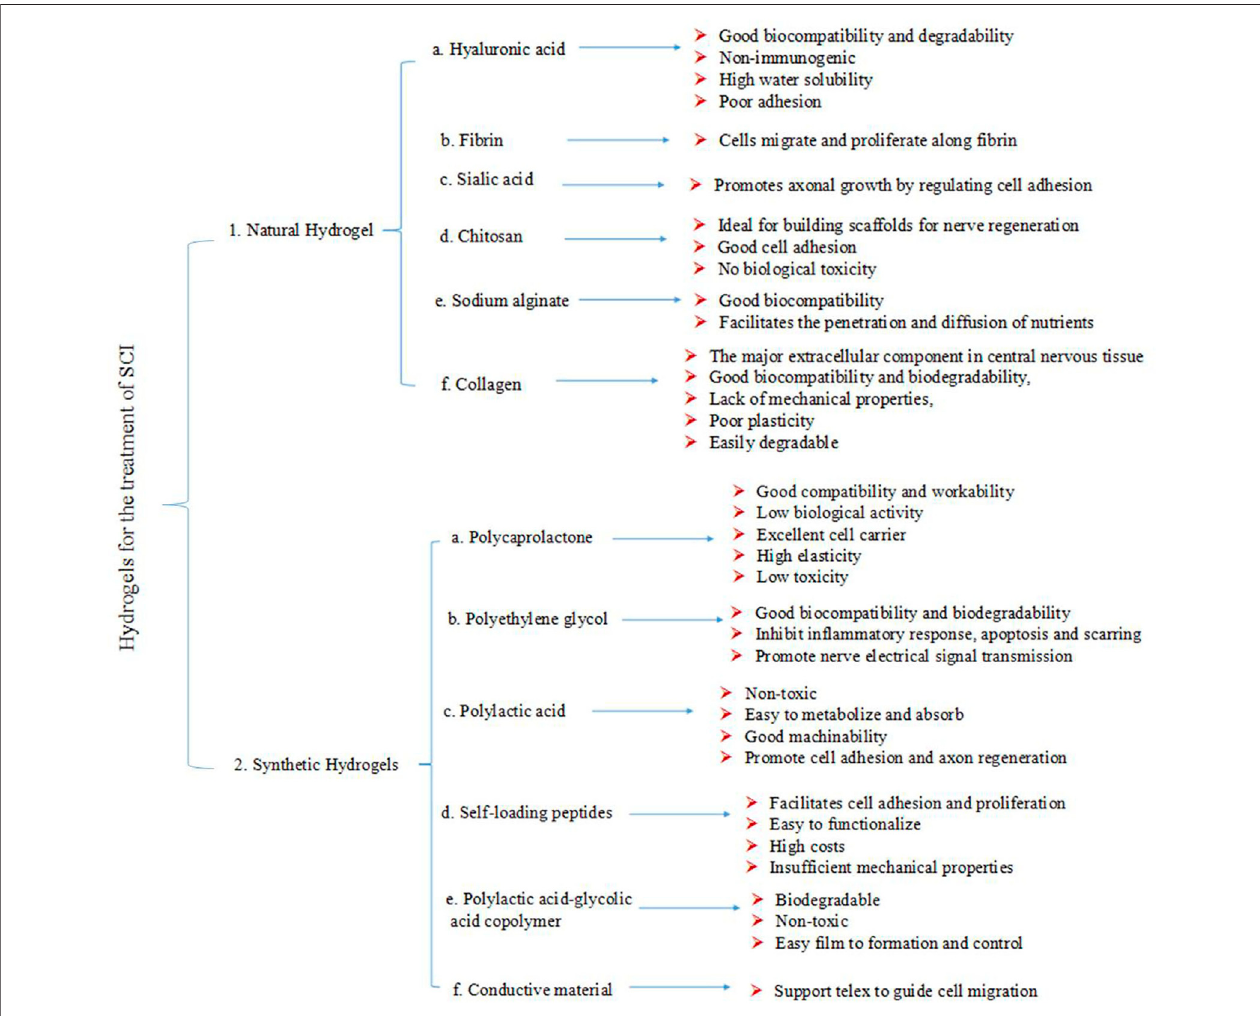
FIGURE 4 | Application and characteristics of hydrogels